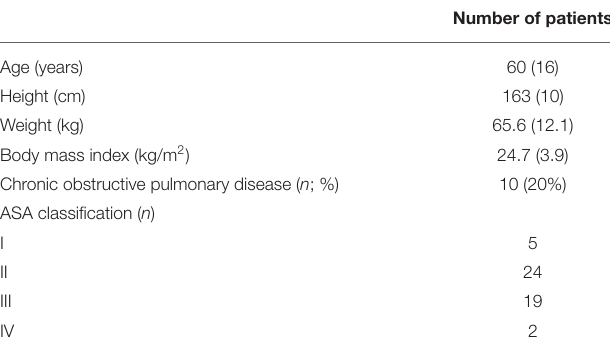
TABLE 1 | Patient